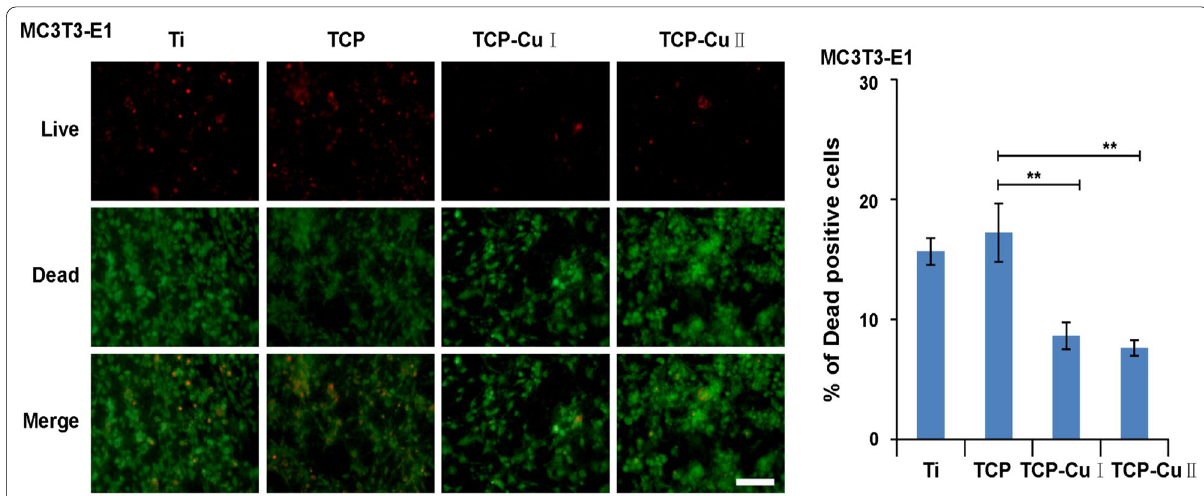
Fig. 8 Staining of living/dead cells on the surfaces of different samples (Data are presented as mean